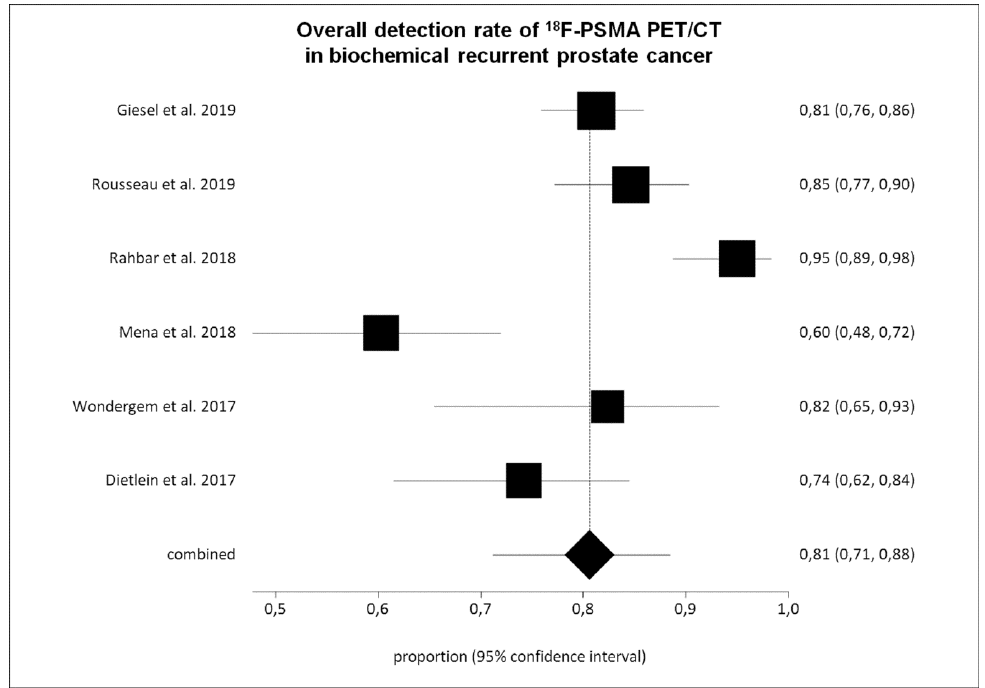
Figure 3. Plots of individual studies and pooled detection rate of 18 F-PSMA PET/CT in biochemical recurrent prostate cancer on a per patient-based analysis, including 95% confidence intervals (95% CI). The size of the squares indicates the weight of each study.